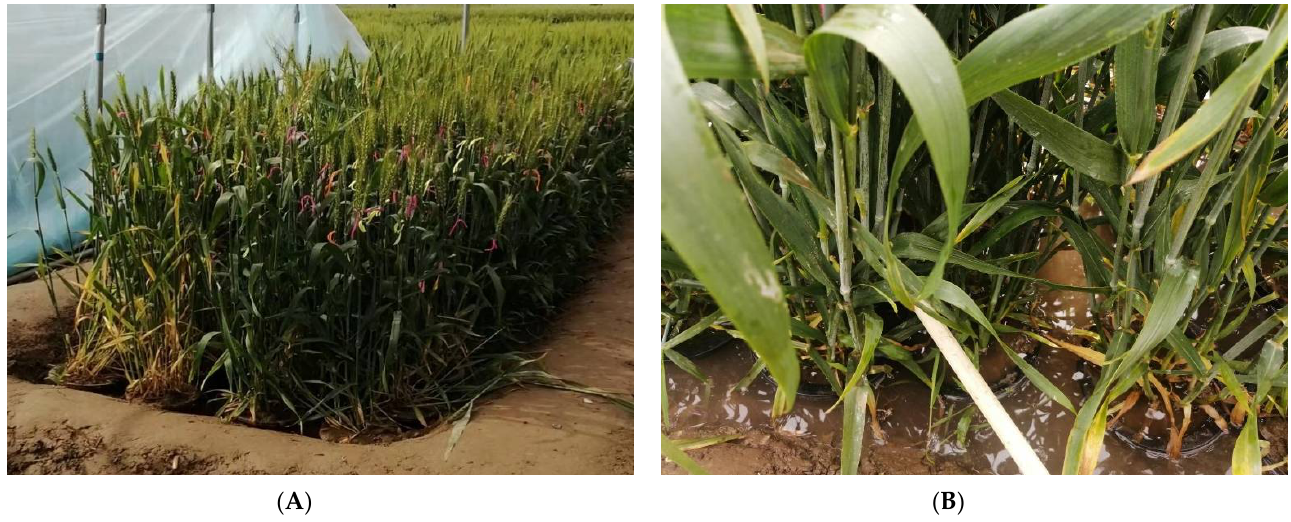
Figure 1. The field under the soil water treatment: the pool ( A ) and the pots under waterlogging ( B ). Following waterlogging treatment, the pots were removed from the water and allowed to drain freely, and the plants were irrigated normally until maturity. Melatonin or distilled water was evenly sprayed one day before and after each waterlogging event. A hand sprayer was used to supply 100 µ M of melatonin on foliage to both waterlogged and non-waterlogged plants for melatonin treatments. The other two groups of plants were sprayed with distilled water. Tween-20 (0.01%) was added with both melatonin and distilled water. Daily weather data for precipitation and temperature were obtained from a nearby automated weather station located in Lujiang County. The weather data and the treatment time are shown in Figure